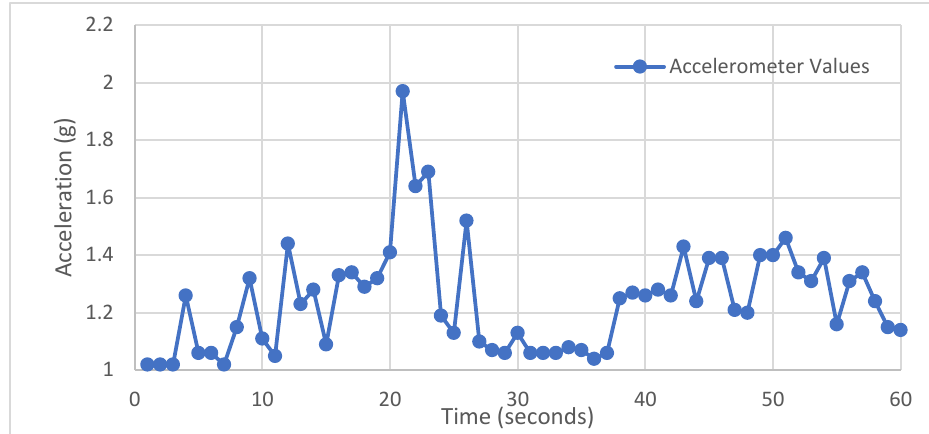
Figure 4. Ordinary movements .